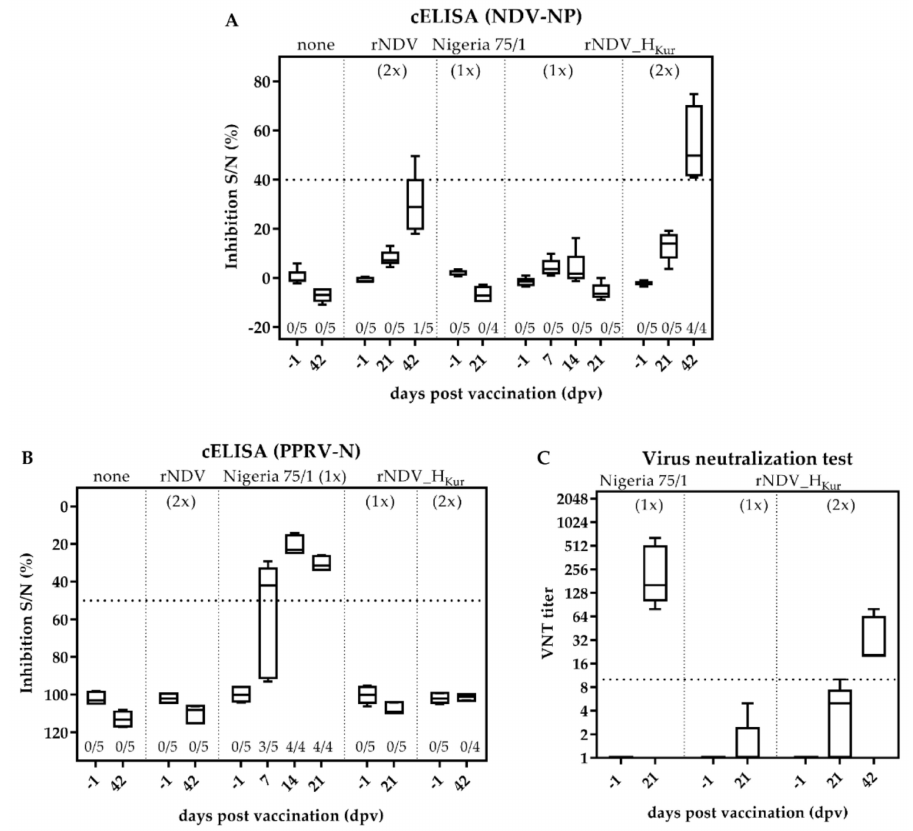
Figure 5. Serology after vaccination. Five goats each were either left unvaccinated (group 1), double inoculated with rNDV (group 2), single vaccinated with PPRV Nigeria 75 / 1 (group 3), single vaccinated with rNDV_H Kur (group 4), or double vaccinated with rNDV_H Kur (group 5). Sera were taken at indicated days after vaccination (dpv) and analyzed for the presence of antibodies, specific to either ( A ) NDV NP or ( B ) PPRV N by competitive ELISA (cELISA). A dotted line indicates the respective thresholds. The number of seropositive tested samples and the number of total tested samples are given below the boxplots. ( C ) Sera from goats, vaccinated with PPRV Nigeria 75 / 1 and rNDV_H Kur